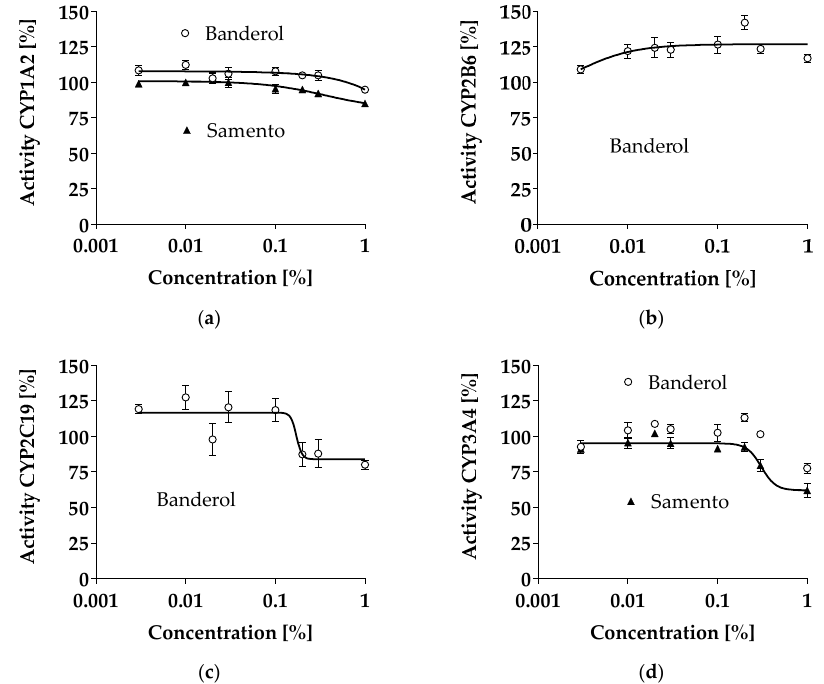
Figure 2. Concentration-dependent effect of Samento and Banderol on the activity of different cytochrome P450 enzymes (CYPs) quantified by P450-Glo ™ Screening Systems. Each curve depicts the results of 3–4 experiments with each concentration tested in octuplet. Data are expressed as mean ± S.E.M. Samento did not change the activity of CYP2B6 and CYP2C19 and data are therefore not shown. ( a ) Inhibition of CYP1A2 by Samento and Banderol. ( b ) Inhibition of CYP2B6 Banderol. ( c ) Inhibition of CYP2C19 by Banderol. ( d ) Inhibition of CYP3A4 by Samento and